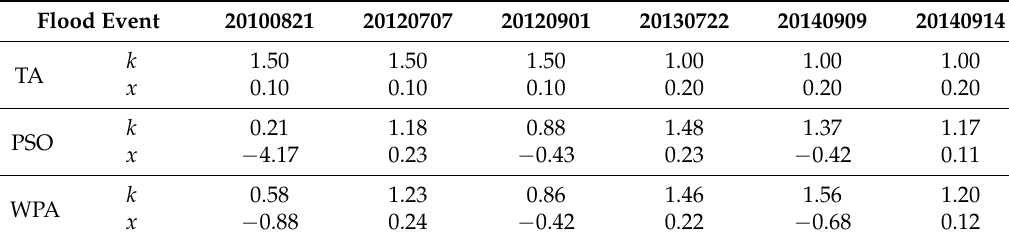
Table 6. Parameter estimation results obtained from different